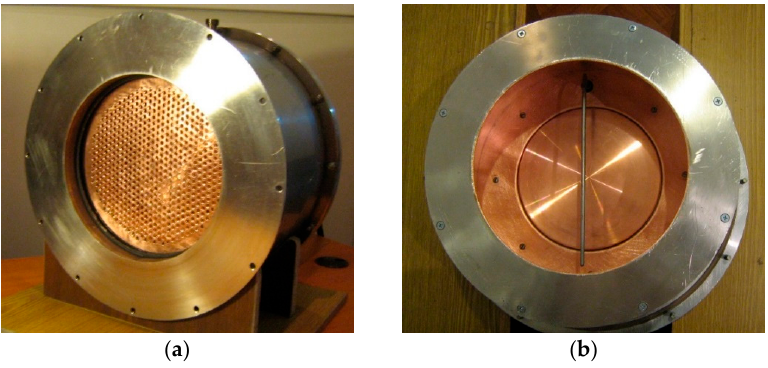
Figure 2. ( a ) The source with the copper grid; ( b ) the L-shaped anode inside the hollow cathode.